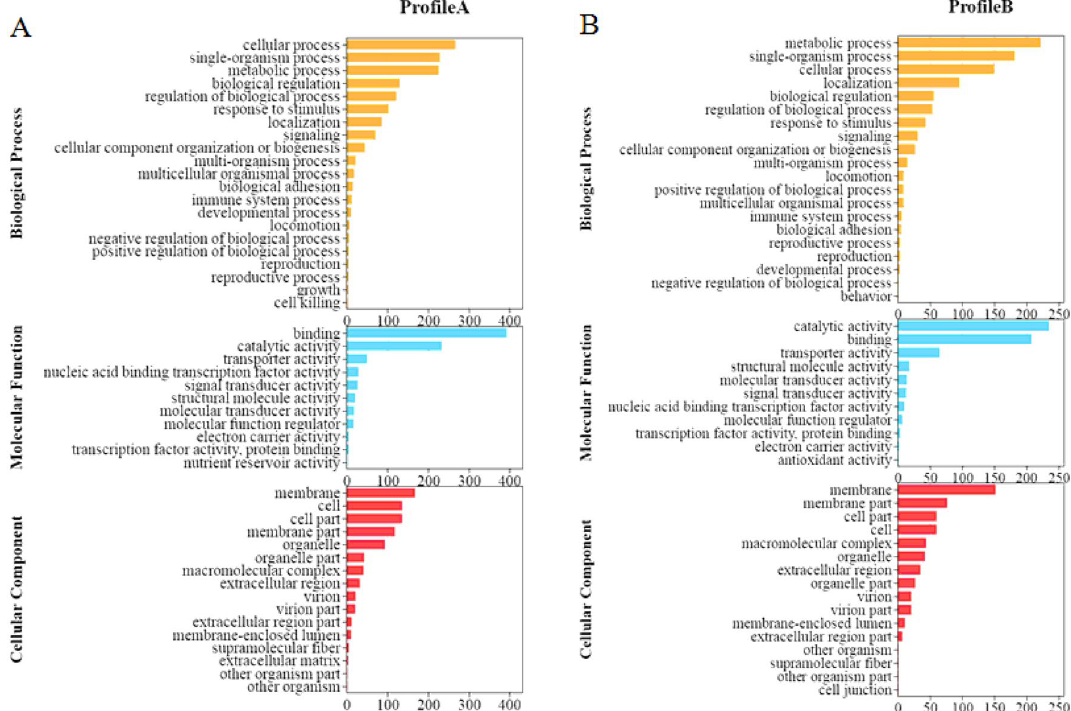
Figure 10. GO enrichment analysis of differential expressed genes.